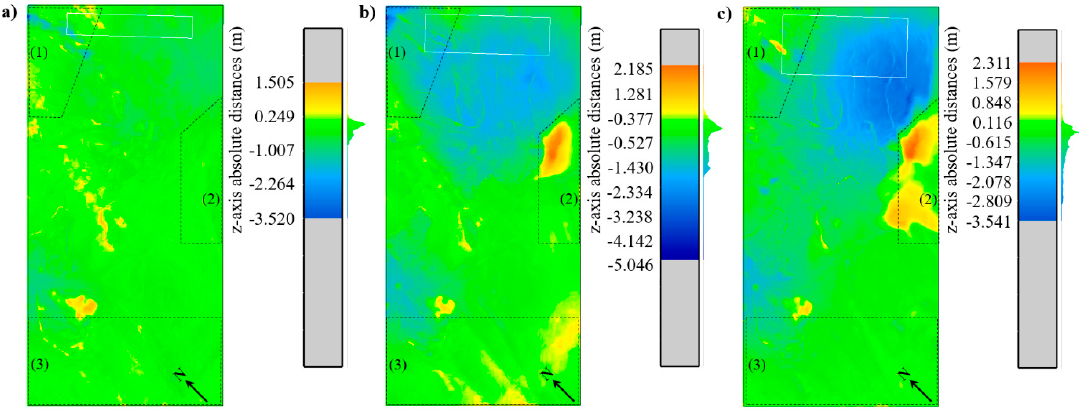
Figure 17. Monitoring data C2C comparison along z-axis: ( a ) Epoch 0–1, ( b ) epoch 0–2, ( c ) epoch 0–3.